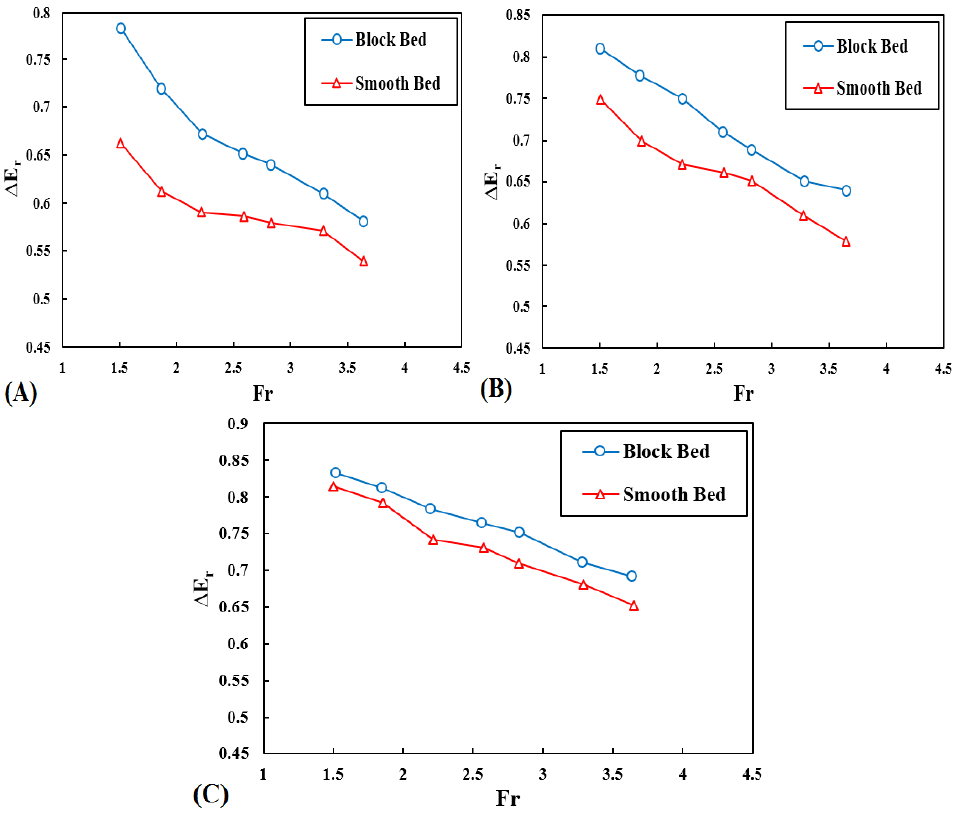
Figure 9. Difference in relative energy dissipation in smooth and block beds. ( A ) Without bucket; ( B ) bucket with θ = 32° ( C ) bucket with θ = 52°.